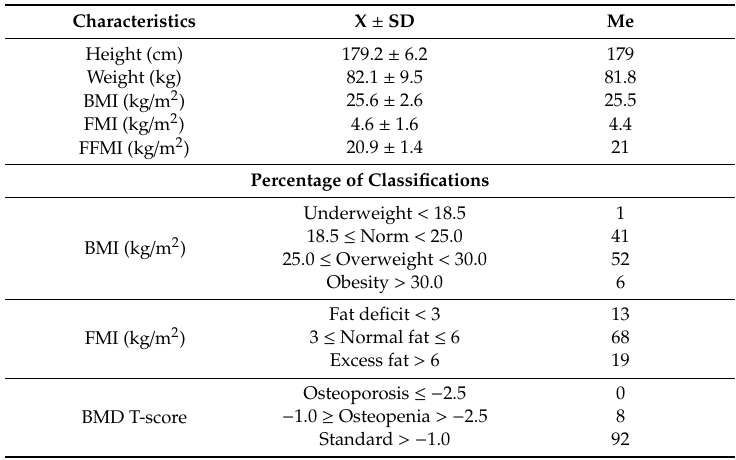
Table 4. Anthropometry and selected nutritional status